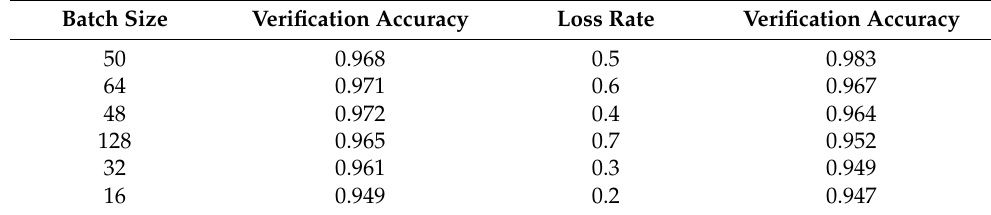
Table 4. The influence of batch size and loss rate on the verification accuracy of